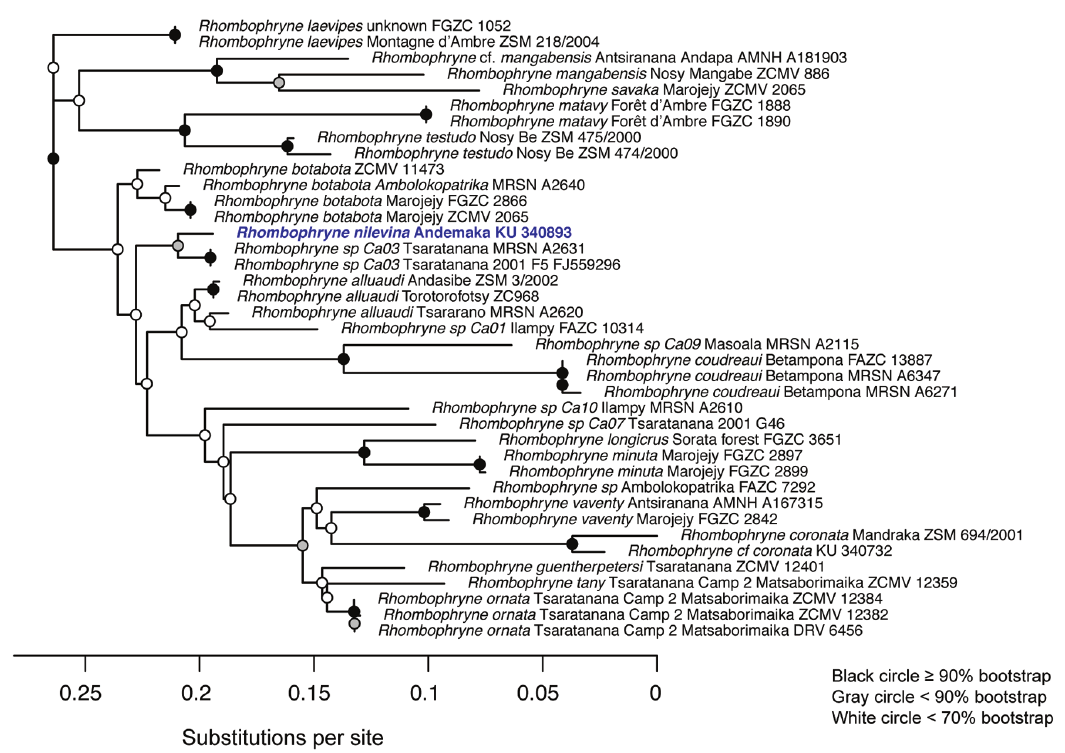
Figure 1. Phylogenetic relationships between Rhombophryne species estimated using maximum likelhood in RaxML using the mi- tochondrial 16S rRNA barcode fragment. Rhombophryne nilevina sp. n. is highlighted with blue bold text. Outgroups are removed from the tree figure for aesthetic